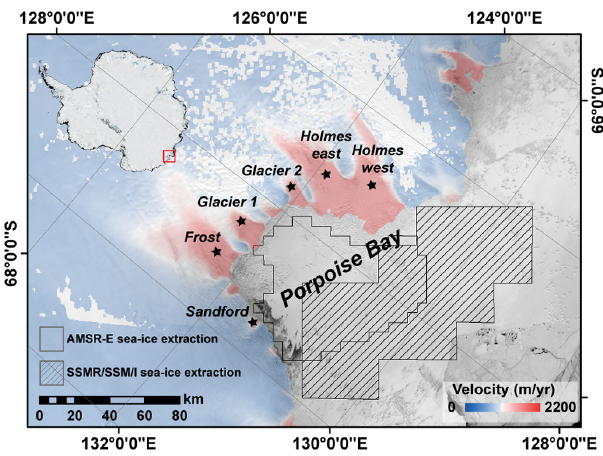
Figure 1. MODIS image of Porpoise Bay, with glacier velocities overlain (Rignot et al., 2011). The hatched polygon represents the region where long-term 25km resolution SMMR/SSM/I sea ice concentrations were extracted. The non-hatched polygon represents the region where the higher resolution (6.25km) AMSR-E sea ice concentrations were